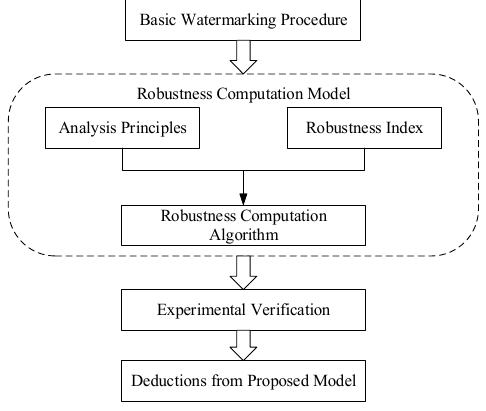
Figure 1. Research diagram to show the robustness computation model.